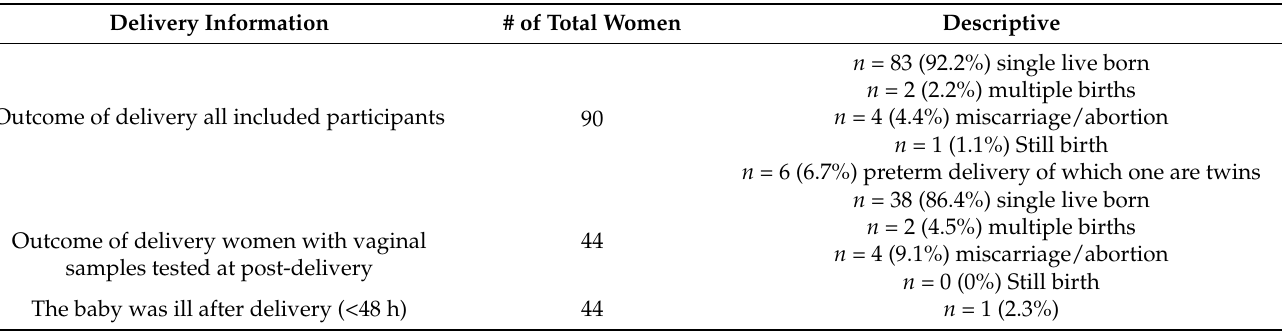
Table 3. Delivery information and pregnancy